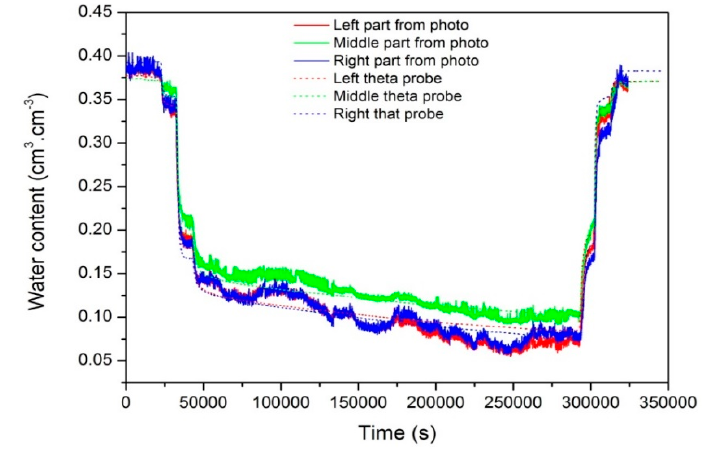
Figure 6. Evolution of the water content in the large flow tank: comparison of the 3 measurements (dotted lines) and results of the photometric procedure (solid lines).